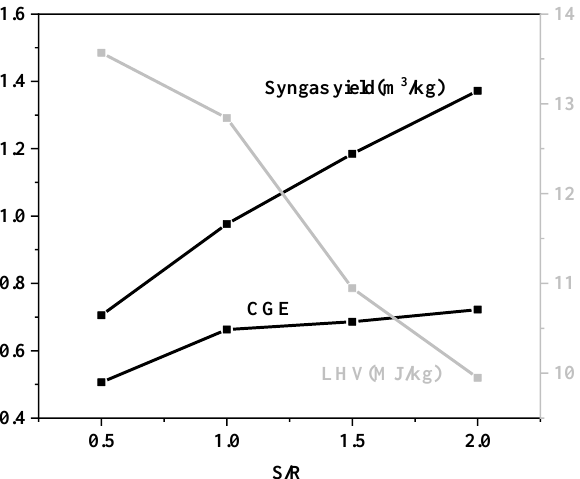
Figure 11. Effect of S/R on the gas distribution.